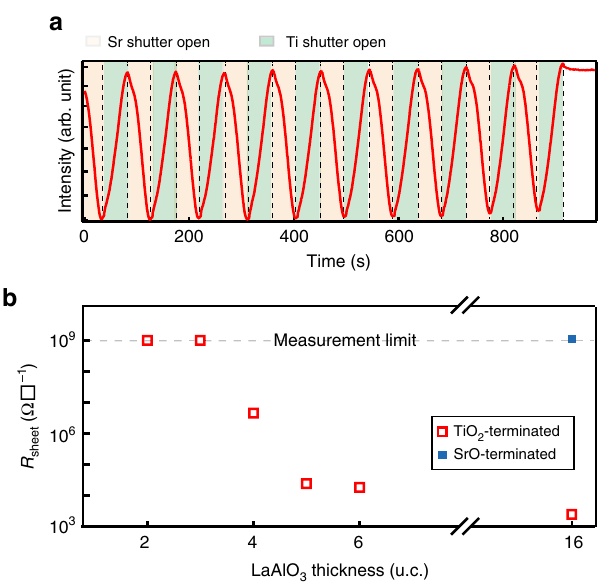
Fig. 4 2DEL of LAO/STO grown on epitaxial SrTiO 3 fi lms. a Out-of-phase RHEED oscillations (only the last 10 cycles are shown) for the growth of TiO 2 -terminated homoepitaxial SrTiO 3 fi lms. b Room-temperature sheet resistivity of the n-type LAO/STO interfaces grown on 60 u.c. thick TiO 2 - terminated epitaxial SrTiO 3 fi lms, showing a critical LAO thickness of 4